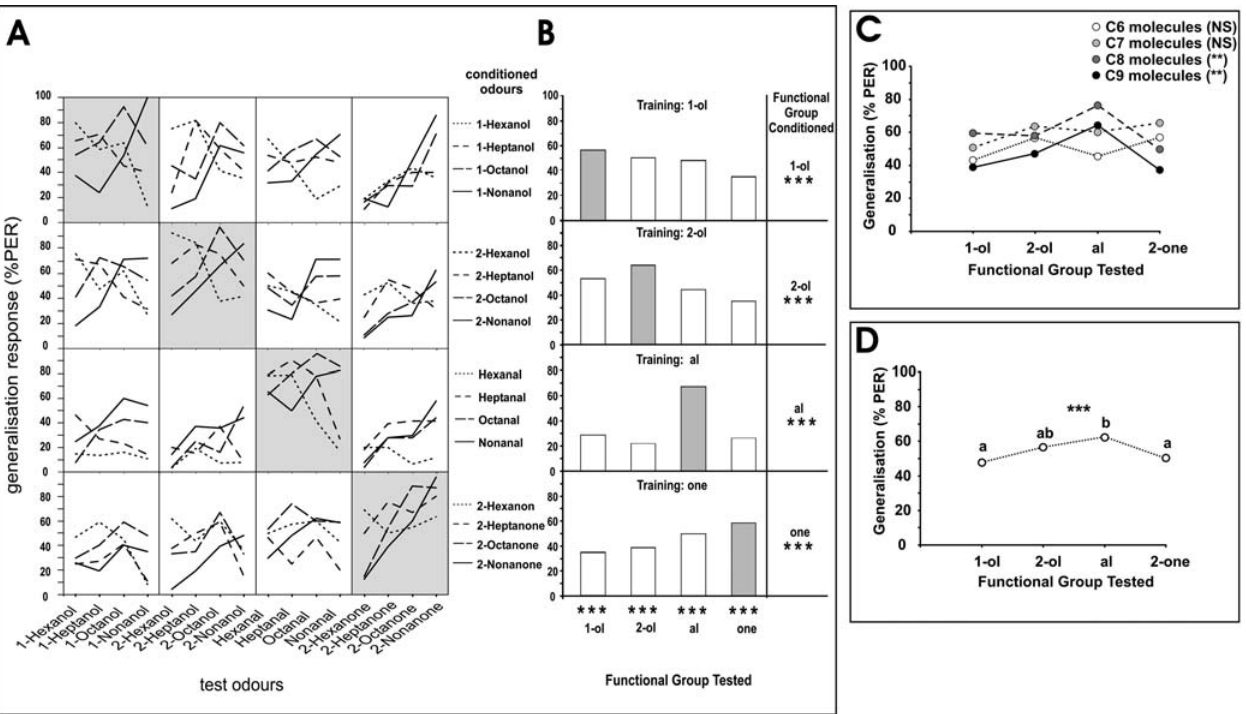
Figure 3. Generalisation Depending on Functional Groups (A) Data of the generalisation matrix (see Figure 2) represented as two-dimensional graphs for each conditioned odour. The right ordinate represents the CSs categorised in four functional groups, primary alcohols, secondary alcohols, aldehydes, and ketones (from top to bottom). The abscissa represents the test odours aligned in the same order as the conditioned odours (from left to right). The left ordinate represents the percentage of proboscis extensions to the test odours after being trained to a given odour. Each quadrant in the figure represents generalisation responses to one functional group after training for the same (grey quadrants) or to a different functional group (white quadrants). (B) Same data as in (A), but the observed responses within each quadrant were pooled and the resulting percentage of responses per quadrant was calculated. The abscissa and the right ordinate represent the four functional groups. The left ordinate represents the percentage of proboscis extensions to each of these groups after being trained to a given group. Grey bars correspond to grey quadrants in (A) and represent generalisation to the same functional group as the conditioned one. White bars correspond to white quadrants in (A) and represent generalisation to a functional group different from the conditioned one: 1-ol, 2-ol, al, and one mean primary alcohol, secondary alcohol, aldehyde, and ketone, respectively. Asterisks indicate significant differences along a row or a column ( p , 0.001) (C) Within-functional group generalisation, depending on chain length. The abscissa represents the functional groups tested. The ordinate represents the percentage of proboscis extensions to the functional groups tested after being trained to a given chain-length (lines). Thus, for instance, the first point to the left for C9 molecules (black circles) represents generalisation to 1-hexanol, 1-heptanol, and 1-octanol after conditioning to 1-nonanol. A significant heterogeneity was found in within-functional group generalisation for C8 and C9 but not for C6 and C7 molecules. (D) Generalisation within-functional groups. The figure shows results from pooling the data of (C) corresponding to each functional group. Each point shows the percentage of proboscis extensions to odours of the same functional group as the conditioned odour. Within-group generalisation was significantly heterogeneous (asterisks, p , 0.001). Pairwise comparisons showed that generalisation within aldehydes was significantly higher than within primary alcohols or ketones and marginally higher than within secondary alcohols (different letters